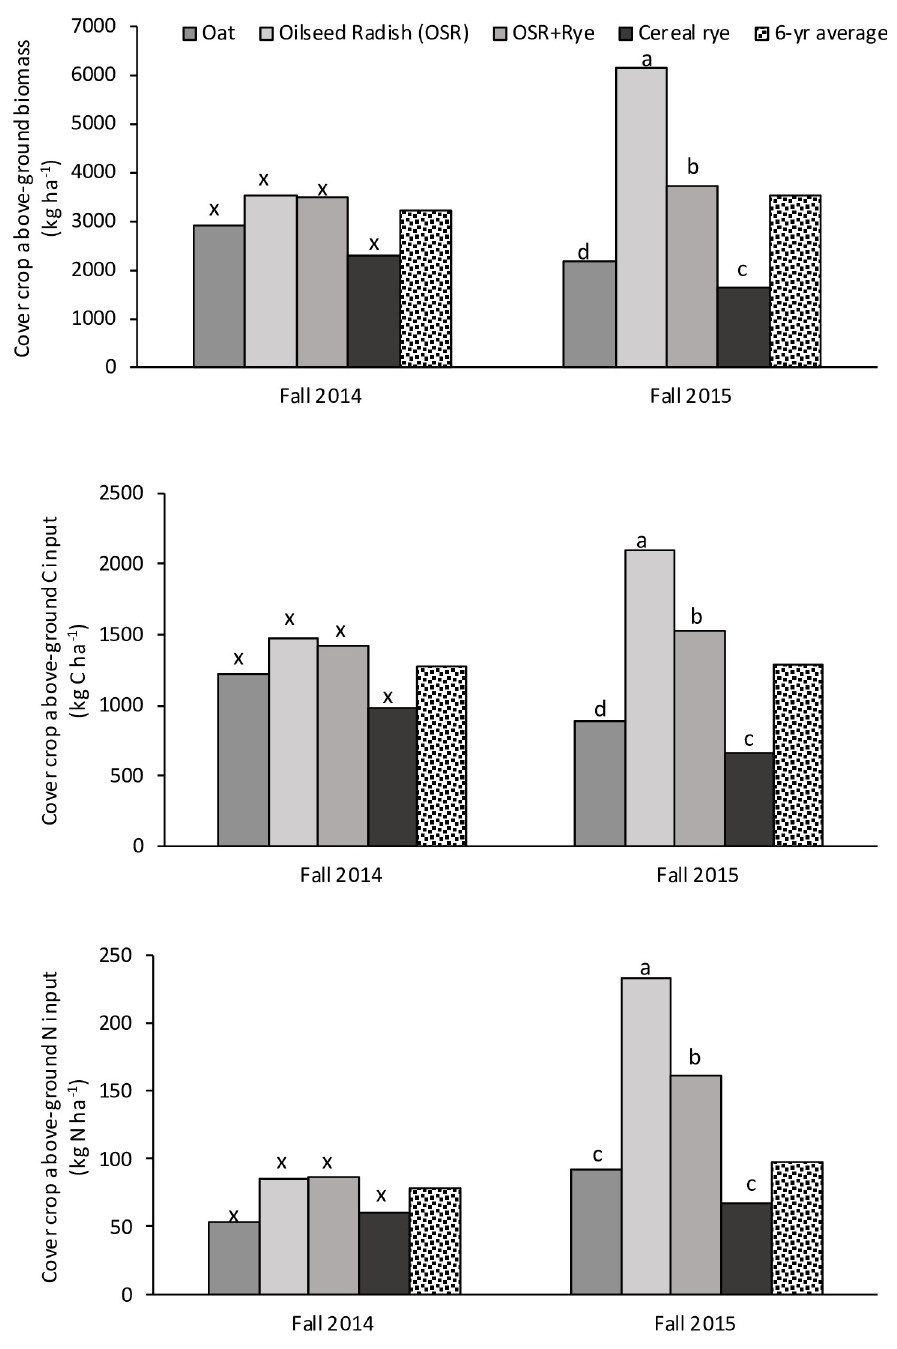
Fig 2. In a medium-term cover crop (CC) experiment, annual above-ground CC biomass, C and N inputs in fall 2014, fall 2015, and average over a period of 6-yrs from various CC treatments. For each parameter in each year, bars followed by a different letter indicate statistical significance per protected LSD test ( P < 0.05; n = 8). -R across all other sampling times; thus, leading to an interaction between sampling time and crop residue treatments (data not shown). Therefore, these results of larger C and N pools of both labile and stable fractions with +R than -R further indicates the potential of +R in increas- ing soil fertility, functionality, and C and N cycling.